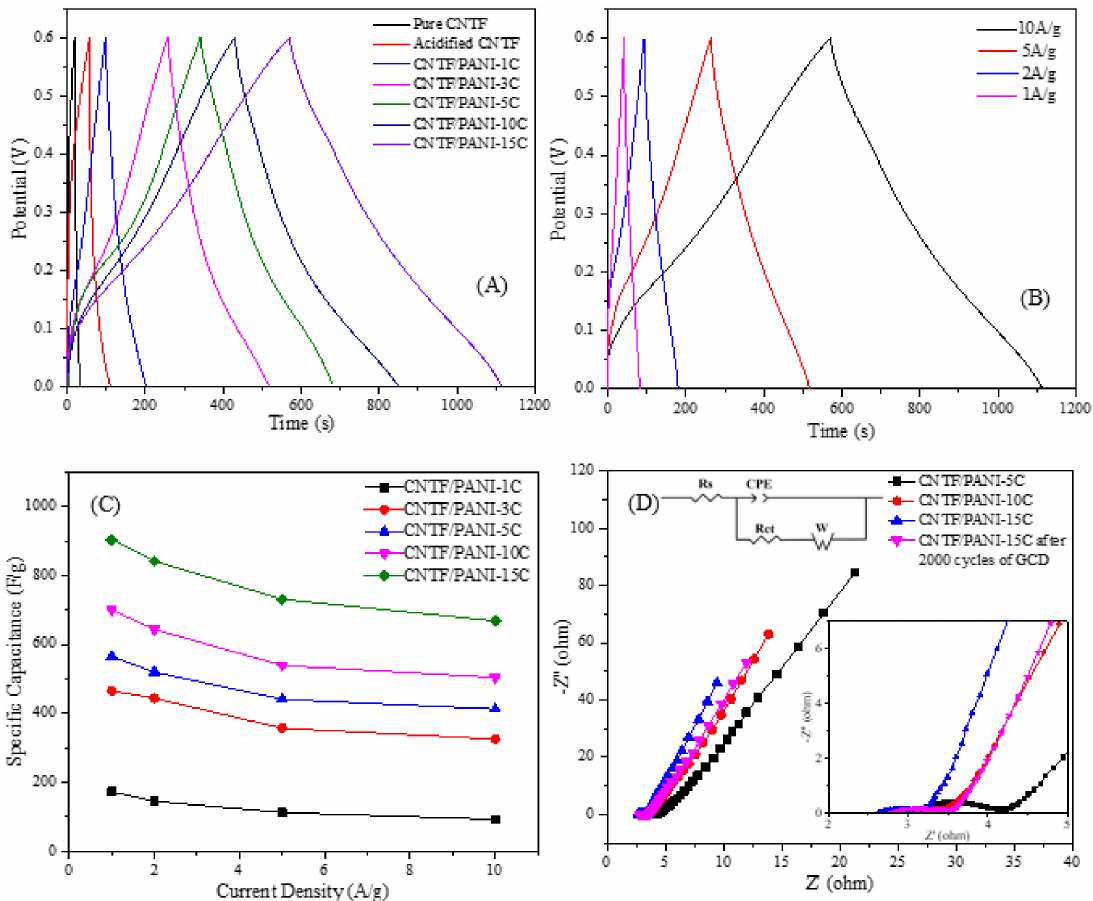
Figure 9. ( A ) GCD curves of pure CNTF, acidified CNTF, and CNTF/PANI nanocomposite electrodes at a current density of 1 A/g in 1.0-M H 2 SO 4 solution; ( B) CNTF/PANI-15C at different current den- sities (1, 2, 5, and 10 A/g); ( C ) The specific capacitances of CNTF/PANI nanocomposites at different current densities; ( D ) Nyquist plots for the CNTF/PANI-5C, CNTF/PANI-10C, and CNTF/PANI-15C nanocomposite electrodes, and the CNTF/PANI-15C nanocomposite electrode, after 2000 cycles of GCD. Inset shows the equivalent circuit for the EIS diagram and the high-frequency